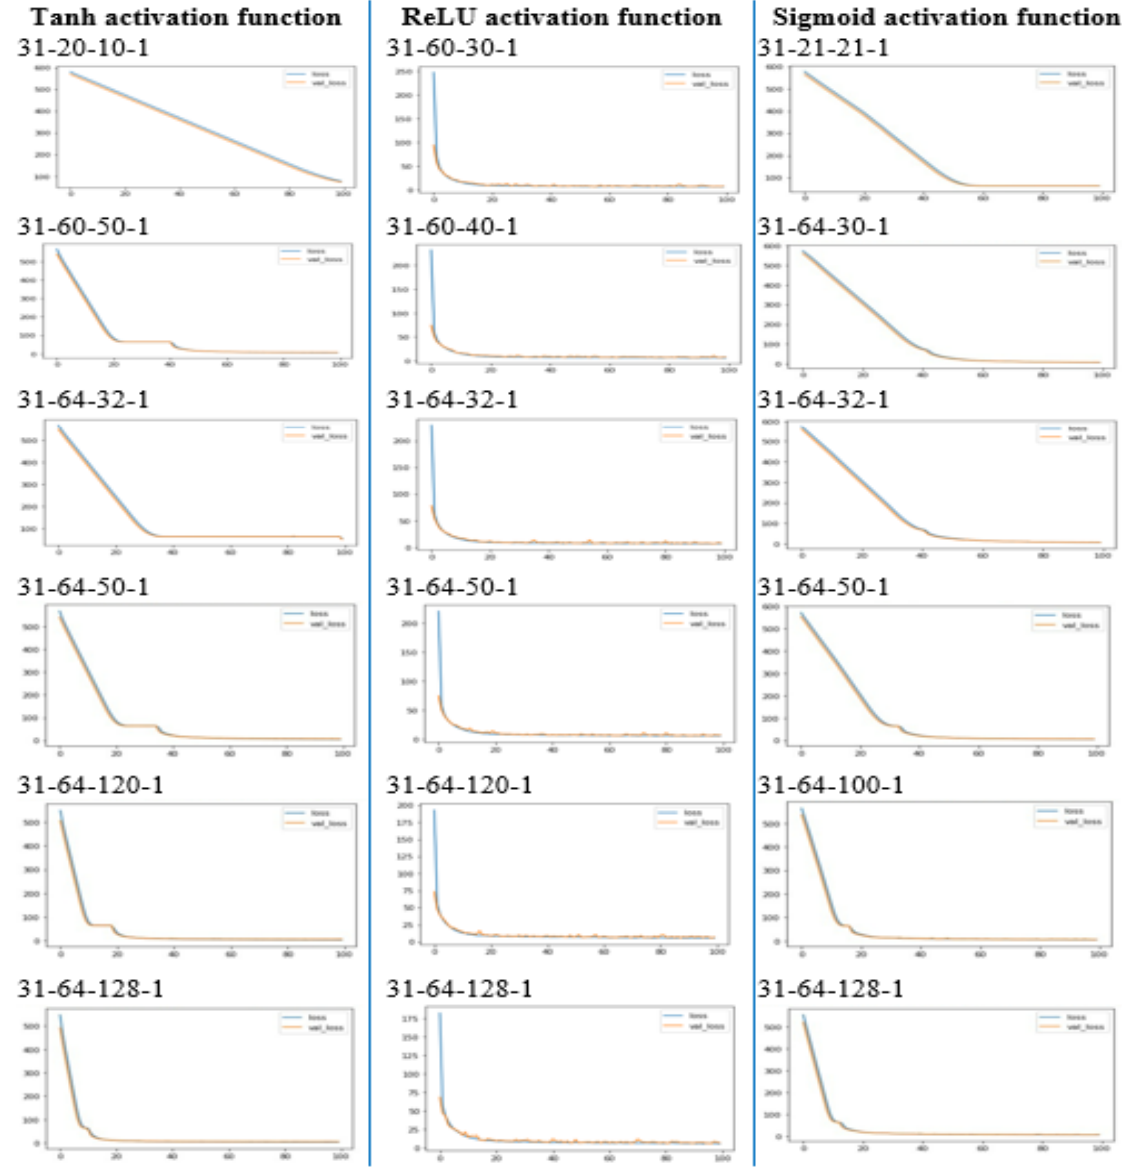
Figure A2. Training loss and Validation loss curves depicting the training performance of the models with three different activation functions for Dehradun and surrounding regions.